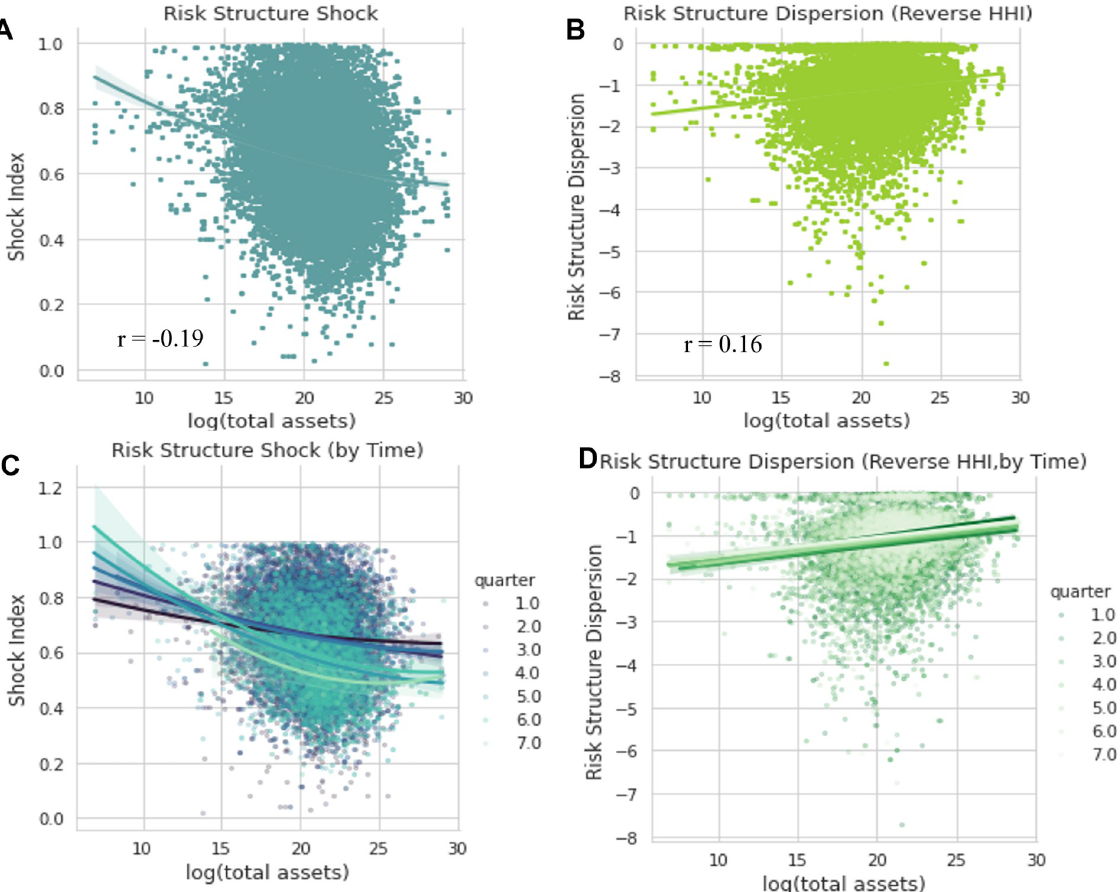
Fig 5. Relationship between risk shock measurements and firm